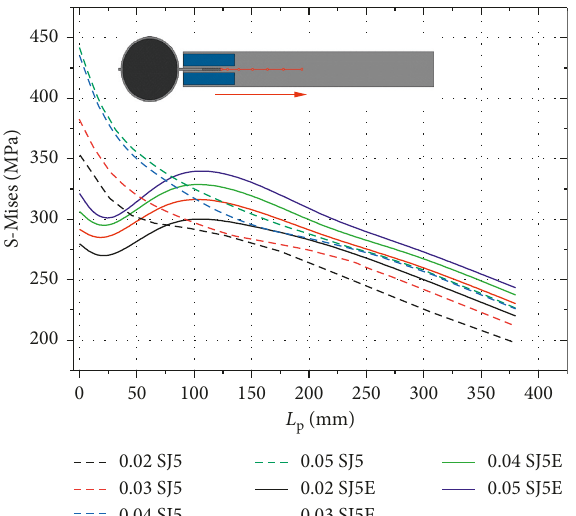
Figure 17: Stress path at beam end at different